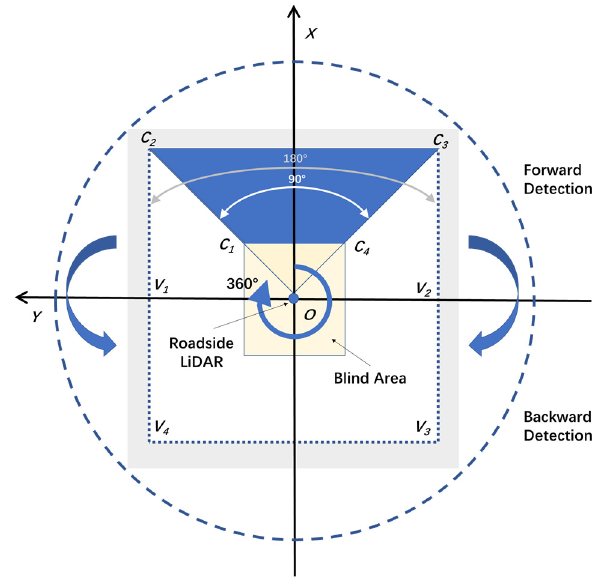
Figure 3. The range and degrees of forward and backward detection.